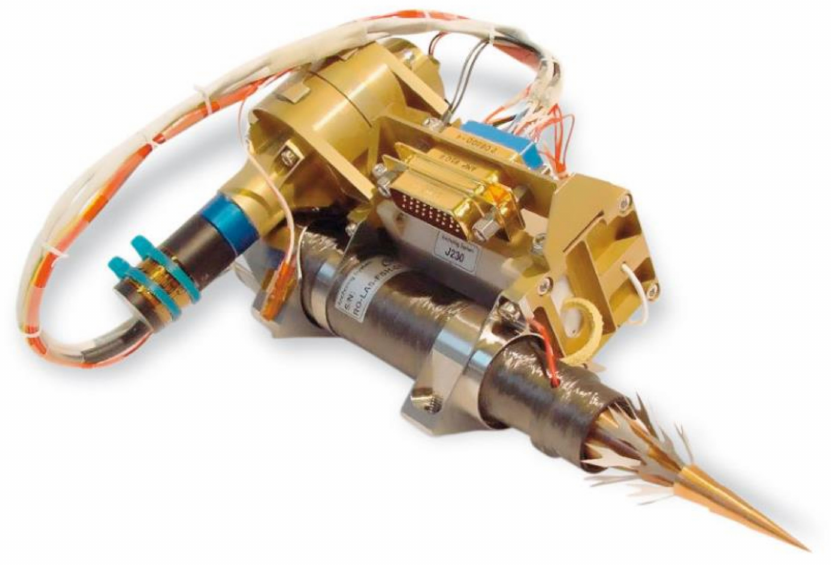
Figure 1. PHILAE lander harpoon used in the Rosetta mission